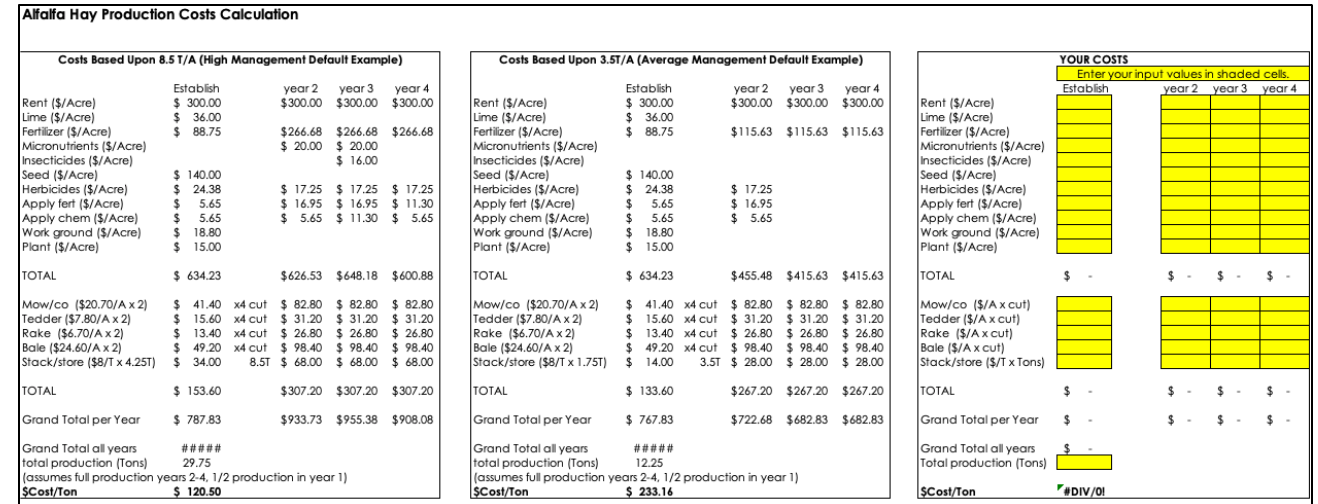
Figure 13. Price of standing hay crop from buyer and grower perspectives developed by PennState Ex- tension. Yellow cells are input fields and the green bordered box indicates the currently selected cell while navigating the spreadsheet.